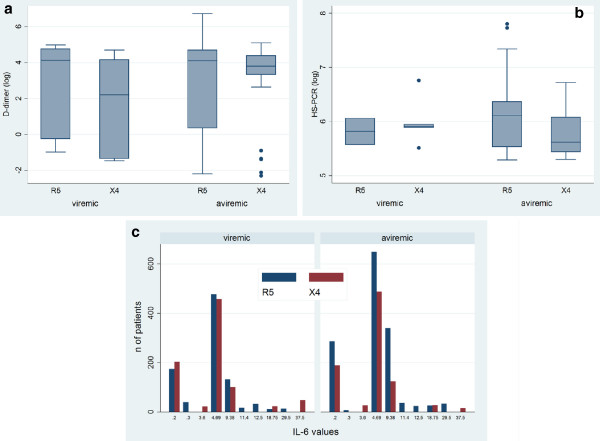
Association of inflammation markers with CRT in viremic and aviremic patients. Secondary adjusted analyses were performed to test whether markers were different according to CRT (R5 vs X4) and viremia (viremic vs aviremic), and both together (test for interaction). Results are showed as: a) and b): box and whiskers plot for log D-dimer (ng/ml) and log hs-PCR (ng/ml) (continuous variables), respectively, with breakdown for CRT, separately for viremic and aviremic patients; c) bar graph for IL-6 (pg/ml)(ordinal variable), with breakdown for CRT, separately for viremic and aviremic patients. No significant results were found.